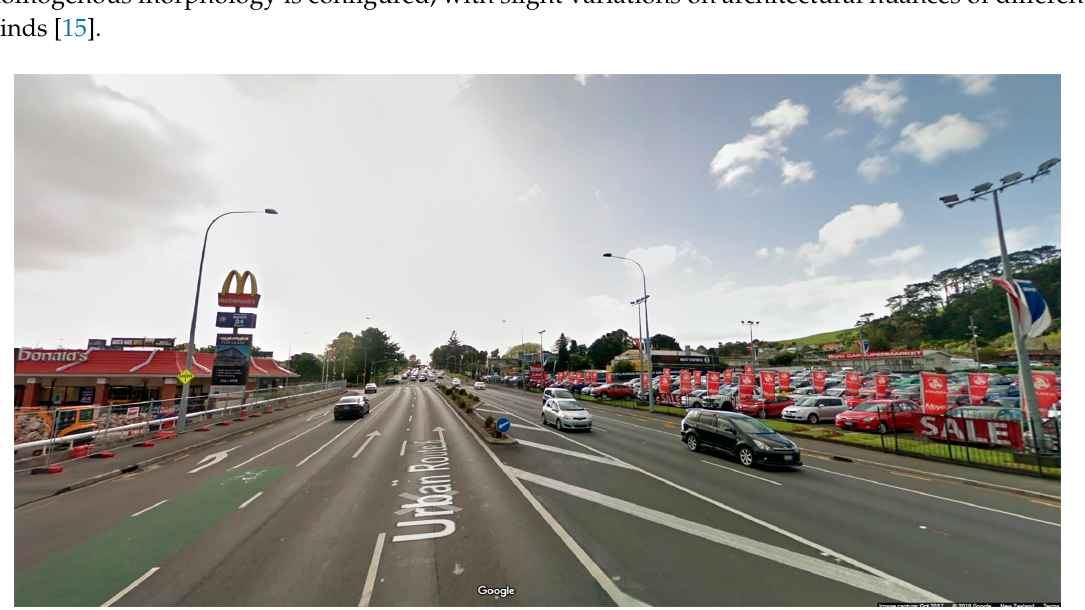
Figure 1. A view of the Ellerslie-Panmure Highway, a typical suburban connection in the suburb of Panmure (Google Street view retrieved in November 2018).